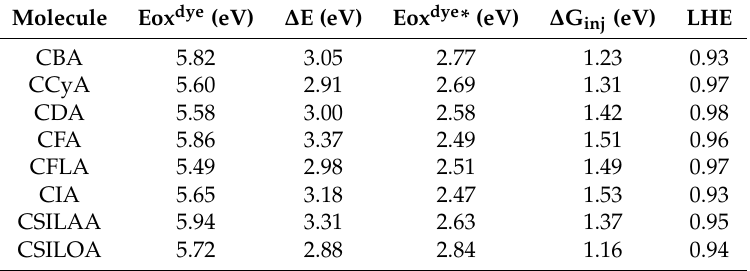
Table 4. Ground-state oxidation potential energy (Eox dye ), absorption energy associated with λ max ( ∆ E), oxidation potential energy of the excited state (Eox dye *), free energy of electron injection ( ∆ G inj ), and light-harvesting e ffi ciency